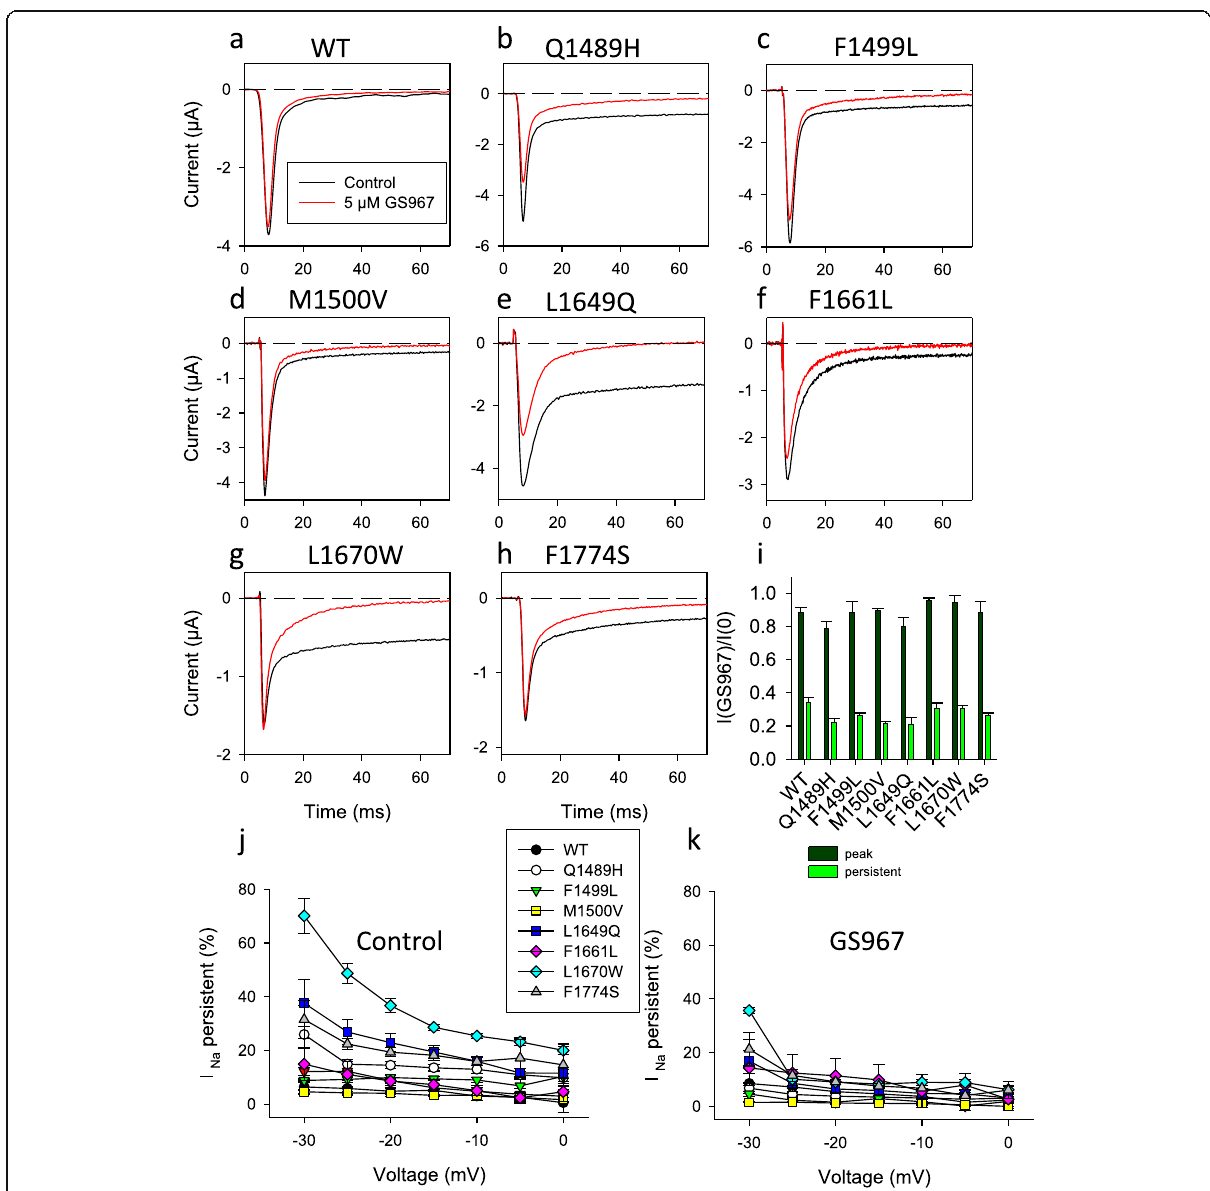
Fig. 3 GS967 blocks persistent currents for WT and all mutants. a - h show typical voltage clamp current responses to a − 30 mV (E), − 25 mV (A, B, C, D, F) or − 10 mV (G, H) pulse before (black traces) and after application of 5 μ M GS967. The different voltages were chosen to maximize current amplitudes, which depended on the reversal potential. In particular, oocytes expressing mutants with large persistent currents had a negatively shifted reversal potential due to sodium accumulation. In panel i the average reduction induced by GS967 of peak currents and current at the end of the 70 ms test pulse is expressed as I (after GS967 application) / I (before application). j and k show relative persistent currents before ( j ) and after ( k ) application of GS967. GS967 significantly decreases persistent currents at all voltages ( p <